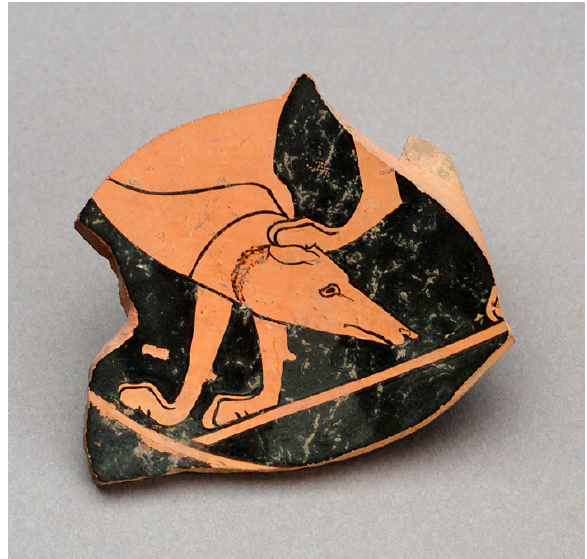
Figure 7. Dog scratching itself (MFA acc. no. 2001.171); kylix fragment; Euergides Painter, ca. 500. Image courtesy of the Museum of Fine Arts, Boston.